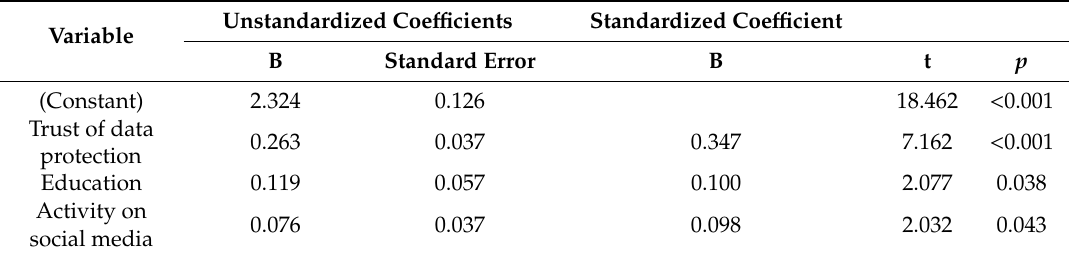
Table 2. Linear regression model: willingness to receive medical services and other variables. Variable